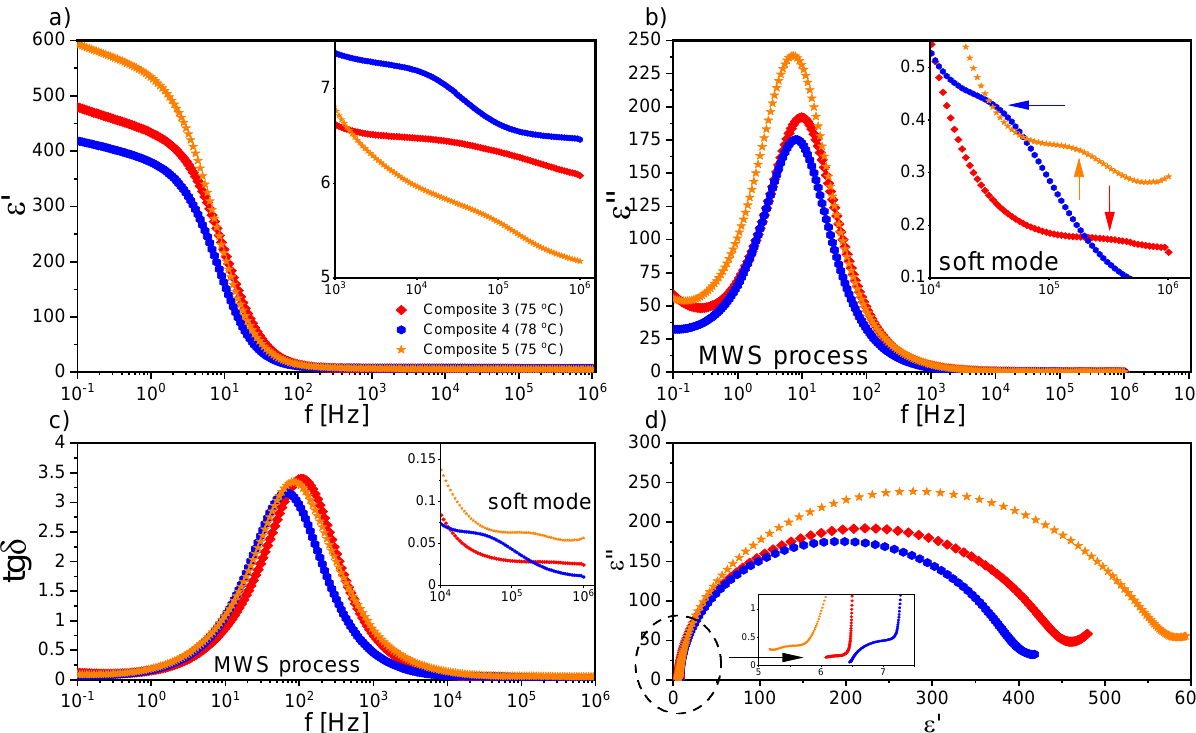
Figure 7. Dielectric dispersion ( a ) and absorption ( b ), loss tangent versus frequency ( c ), and Cole–Cole plot ( d ) for Composites 3–5 in the TGBA*/SmA* phase. Insets present the high-frequency range. The legend in graph ( a ) is the same for all graphs.